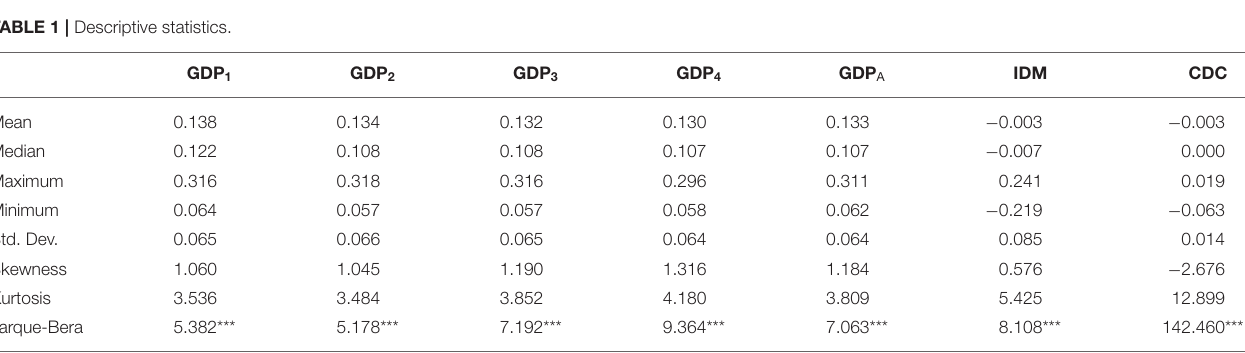
TABLE 1 | Descriptive